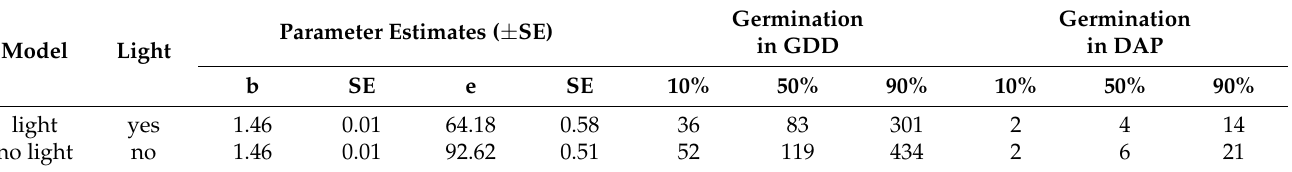
Table A2. Effects of light on cumulative germination of 10%, 50%, and 90% of seeds in 26 populations of Cuscuta campestris over growing degree days (GDD) and days after planting (DAP) and by regions (Banat, Srem, and Macva).